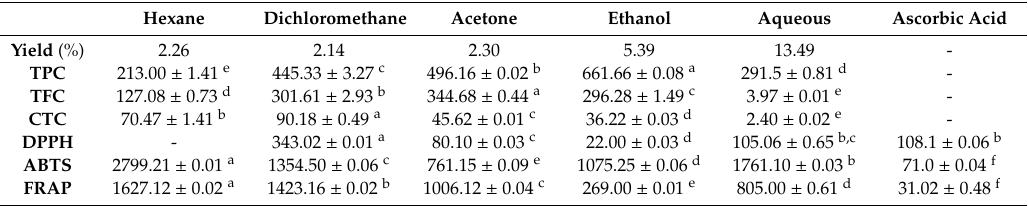
Table 1. Extraction yield (%), total polyphenolic (TPC mgGAE / g), total flavonoid (TFC mgQE / g) and condensed tannins contents (CTC mgCE / g), DPPH radical-scavenging activity (IC 50 µ g / mL)), 2,2’-azino-bis(3-ethylbenzothiazoline-6-sulphonate (ABTS) (IC 50 µ g / mL) and Reducing Power Assay (FRAP) (CE 50 µ g / mL) of di ff erent extracts of Oudneya Africana leaves. Hexane Dichloromethane Acetone Ethanol Aqueous Ascorbic